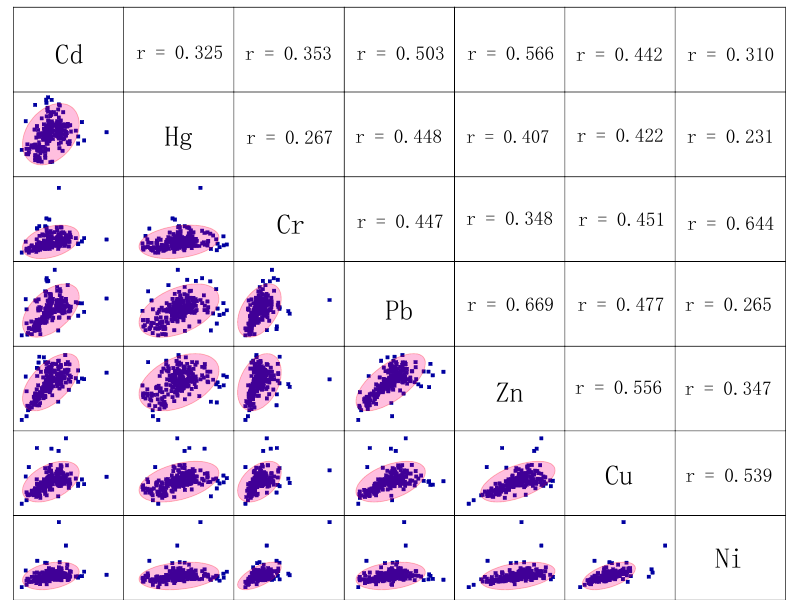
Figure 5. Correlation coe ffi cients (95% confidence interval) and scatter diagrams for heavy metal matrixes in Shijiazhuang street dust (particles smaller than 74 µ m).